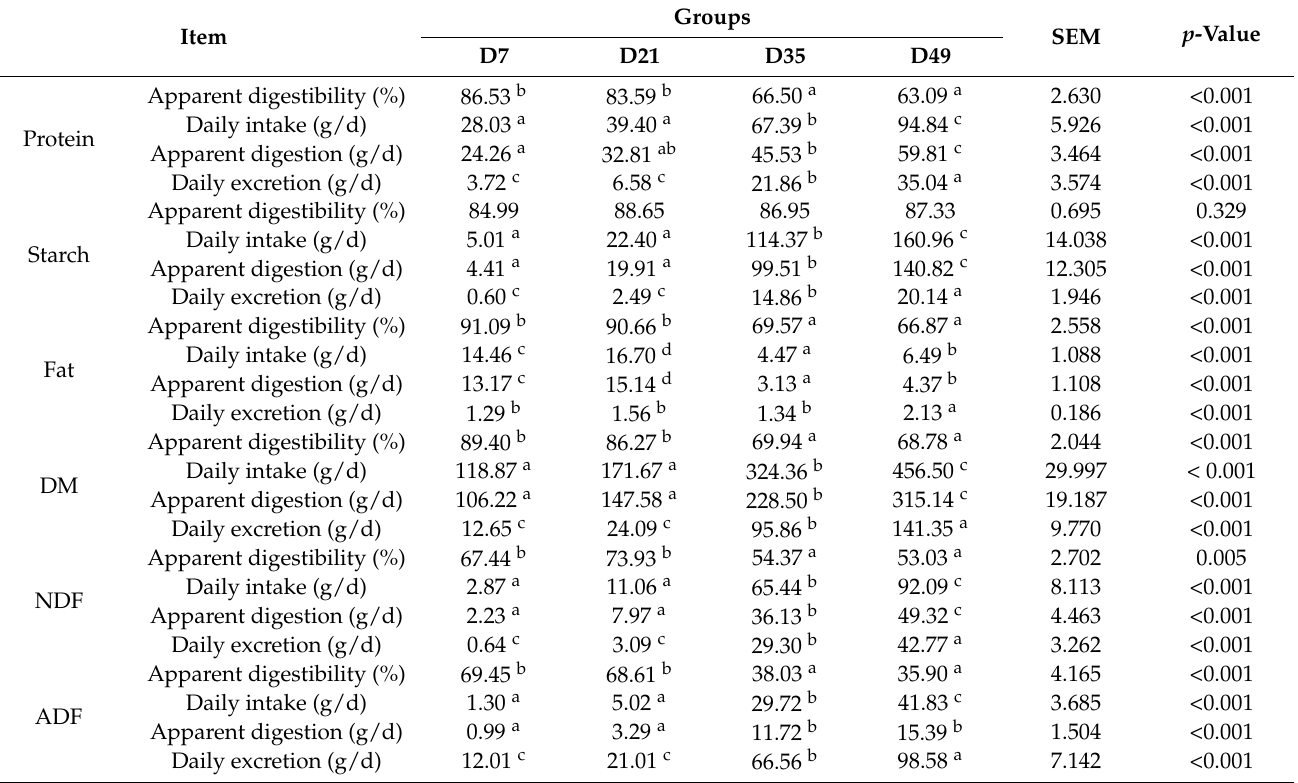
Table 5. Effects of different sampling times on apparent digestibility in early